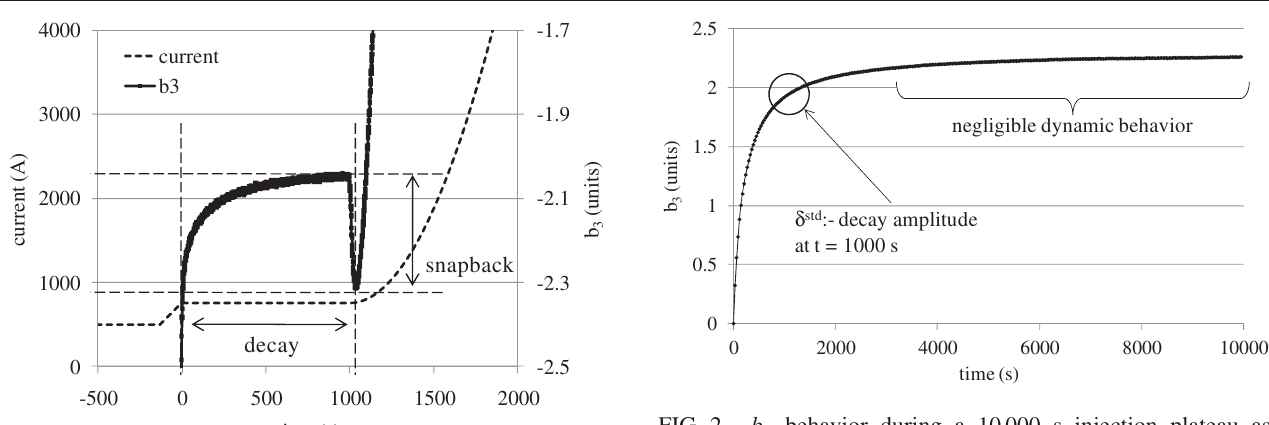
FIG. 2. b 3 behavior during a 10 000 s injection plateau as measured in MB3028. The values have been shifted along the y axis to cancel the initial value.